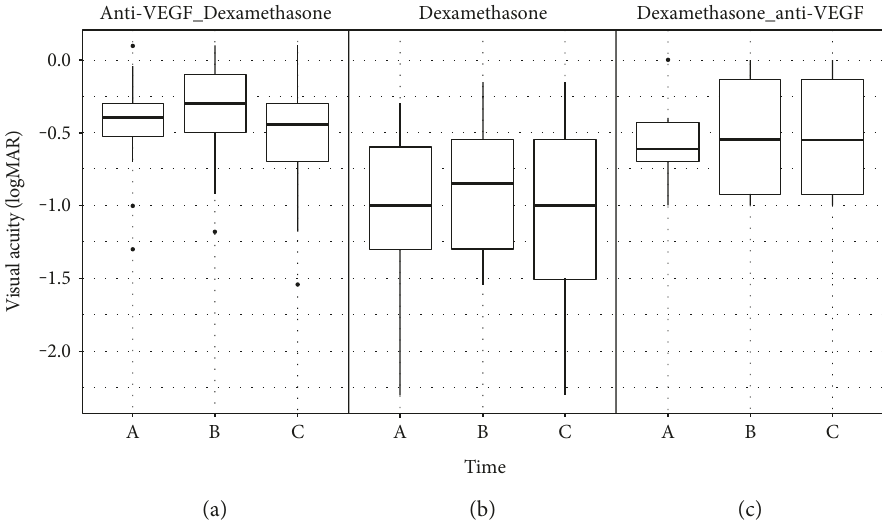
Figure 1: Mean BCVA improvement after dexamethasone implant in anti-VEGF refractory eyes was 4 letters ((a) change in logMAR 0.42 to 0.36, p = 0 08 ); treatment naïve eyes gained 10 letters after dexamethasone implant ((b) change in logMAR 1.07 to 0.82, p = 0 66 ), while we noted no signi fi cant change in eyes refractory to dexamethasone implant after switch to anti-VEGF ((c) change in logMAR 0.55 to 0.52, p = 0 74 ). A=BCVA before switch from anti-VEGF to dexamethasone (a) or vice versa (c) or before treatment (b); B=best BCVA after switch/treatment at 88 days [70; 176], 92 days [87; 100], and 123 days [96; 210]; and C =at the end of observation (median follow-up